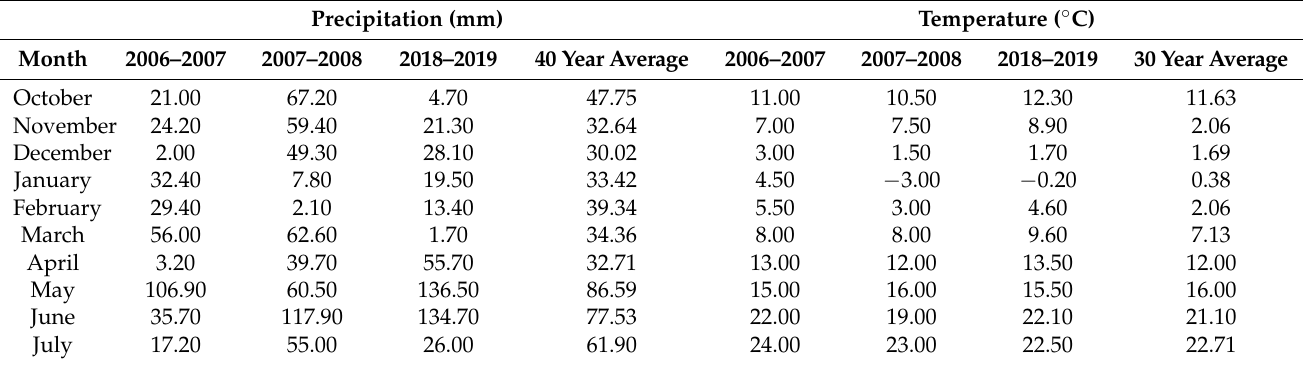
Table A3. Monthly precipitation and temperature in the 3 crop years in